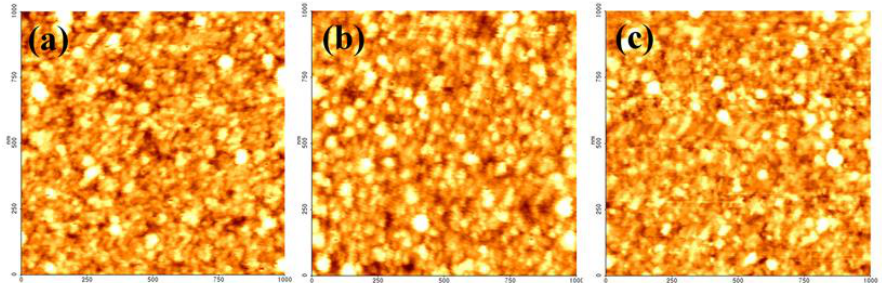
Figure 5. AFM images of the Ru films: ( a ) as deposited, ( b ) after annealing at 300 °C, and ( c ) after annealing at 500 °C.